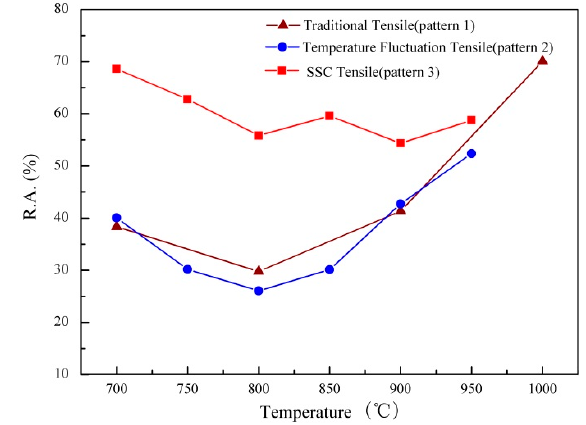
Figure 10. Reduction of area (R.A.) of samples under different thermal schedules.